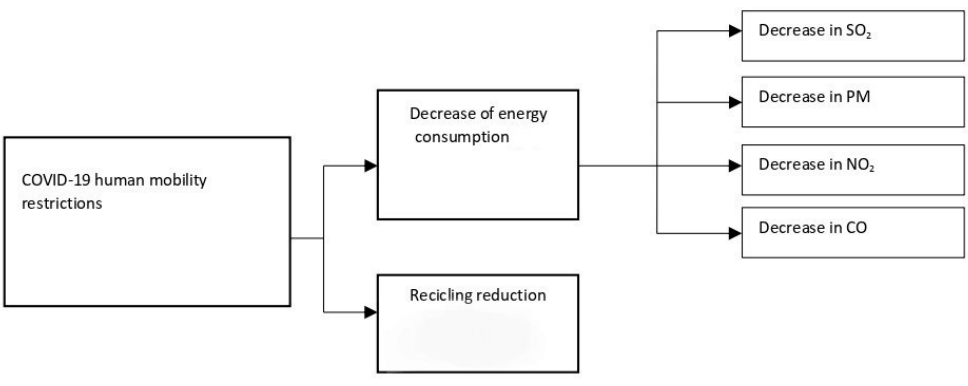
Figure 1. Curtailment restriction implications on public health [13].